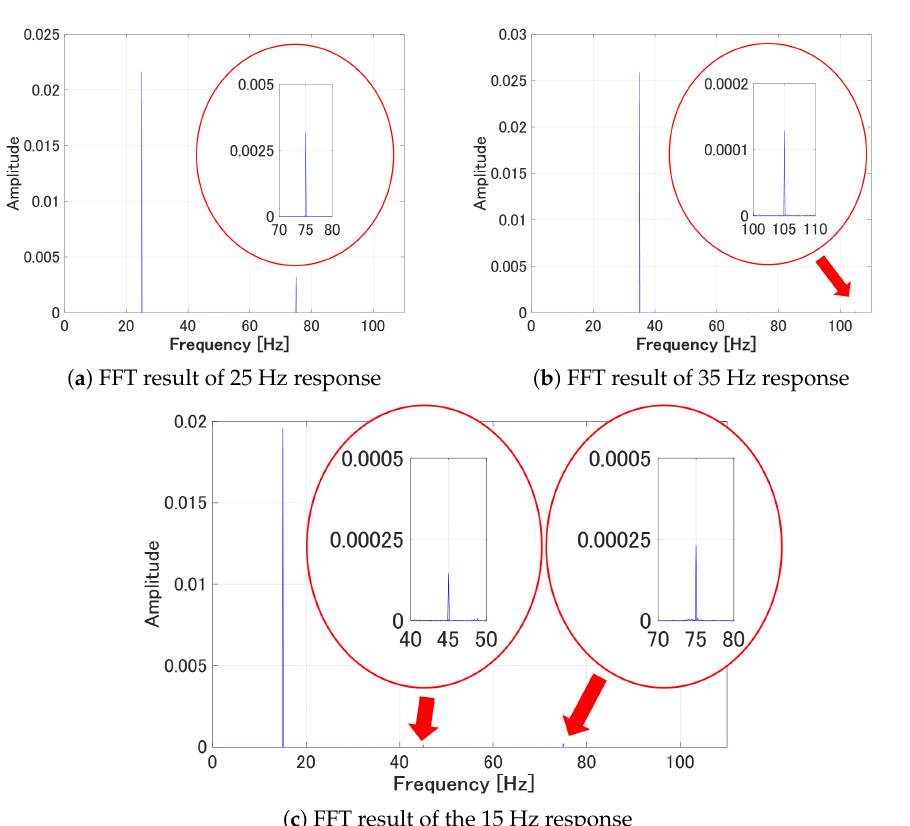
Figure 8. Results of Fast Fourier Transform (FFT) analyses of the response to three different driving